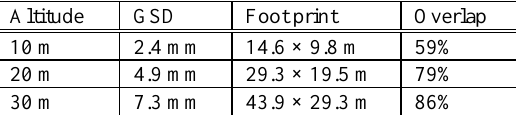
Table 3. Image acquisition